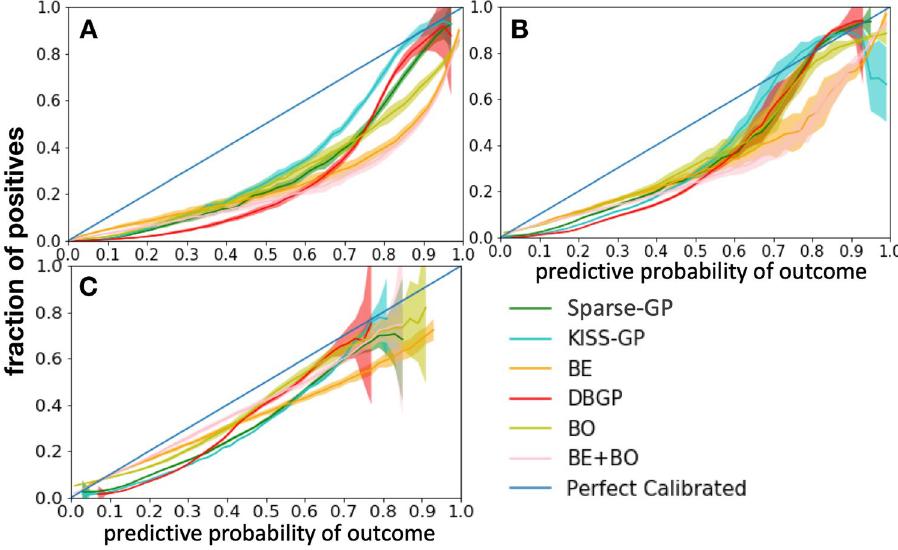
Figure 7. Calibration curve with 95% confidence interval. The x and the y axis represent the predictive probability and the fraction of positive cases, respectively; A: heart failure, B: diabetes, C: